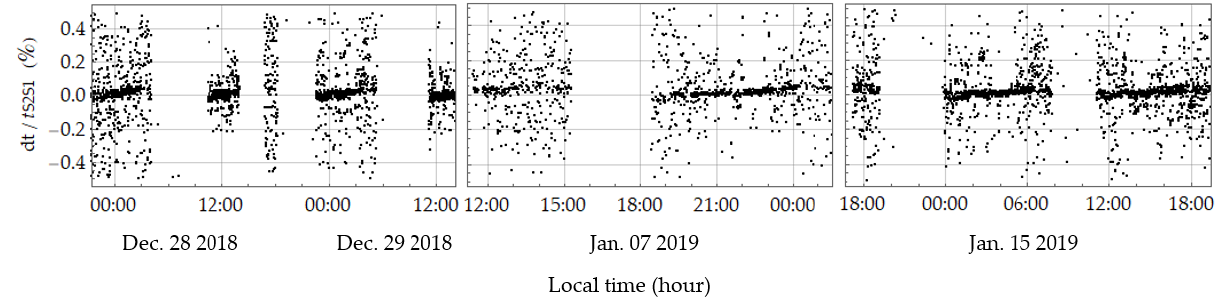
Figure 11. The travel time differences compared to travel time from S2 station to S1 station.